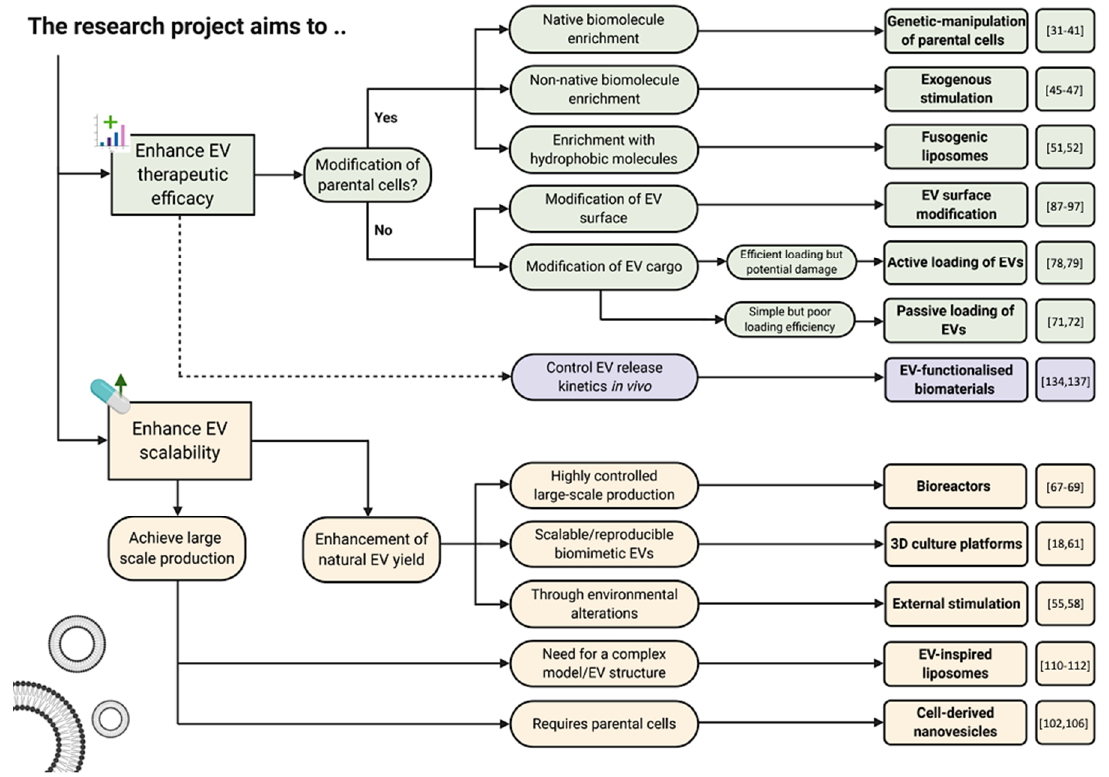
Figure 9. Schematic guide providing an overview of the engineering approaches and technologies currently used to enhance the therapeutic efficacy and scalability of EVs to improve their clinical utility.